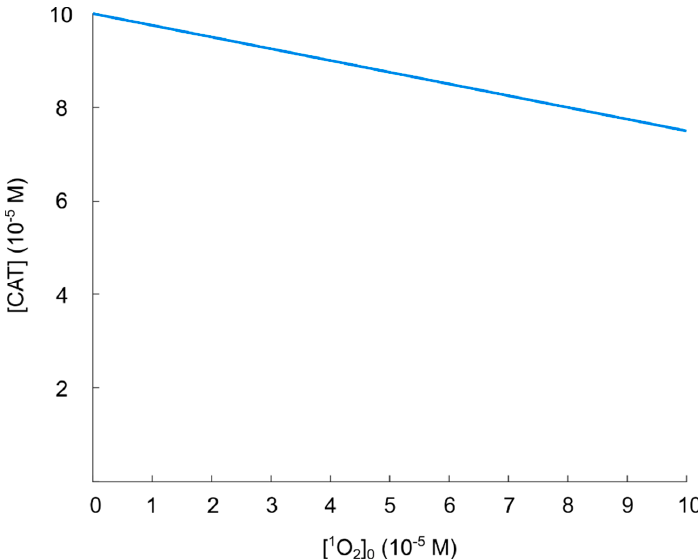
Figure 6. Steady-state concentration of catalase as a function of singlet oxygen concentration.